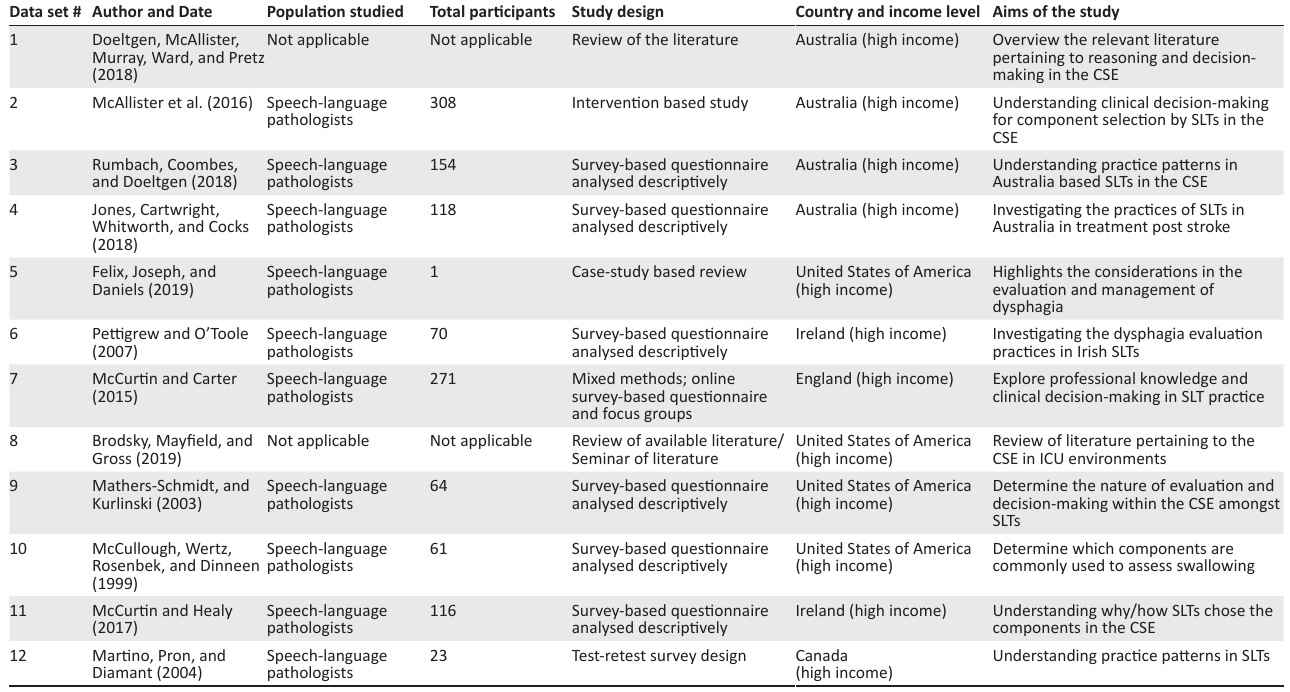
TABLE 1-A2: Characteristics of included